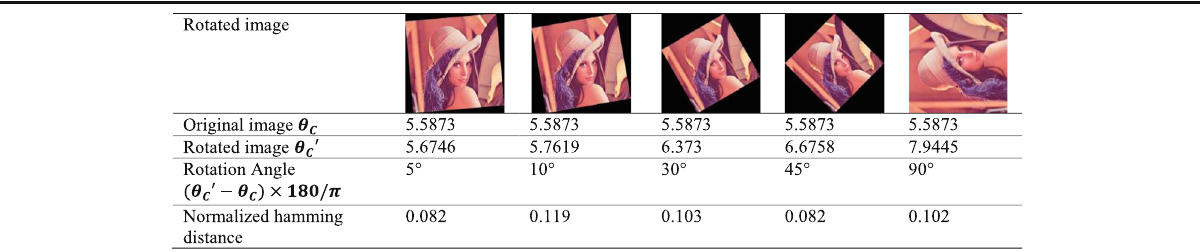
Table 3 Analysis of rotation angle and hash distance for Lena